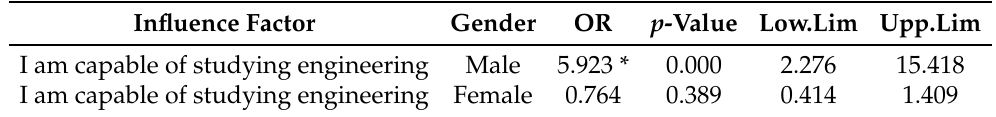
Table 6. Odds ratio, p -value and confidence interval obtained for the study of the advantage of feeling capable for male and female students. An * indicates statistical